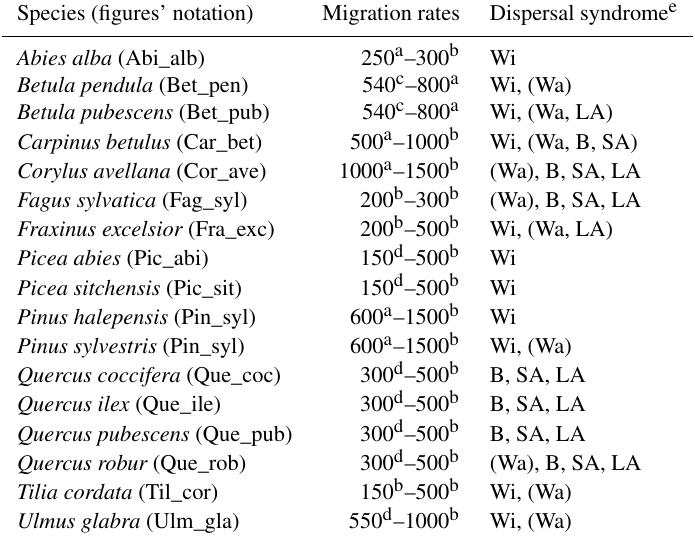
Table 1. Estimates of maximum post-glacial migration rates in metres per year (myr − 1 ) and dispersal syndromes during post-glacial expan- sion for 17 major European tree species. Default competitors in model simulations are Betula pendula (or B. pubescens in the case of the simulated spread of B. pendula ) and boreal and temperate grasses; alternative competitors are tested for Fagus sylvatica (Que_rob), Picea abies (Pin_syl), and Tilia cordata (Que_rob or Pin_syl) (see Sect.